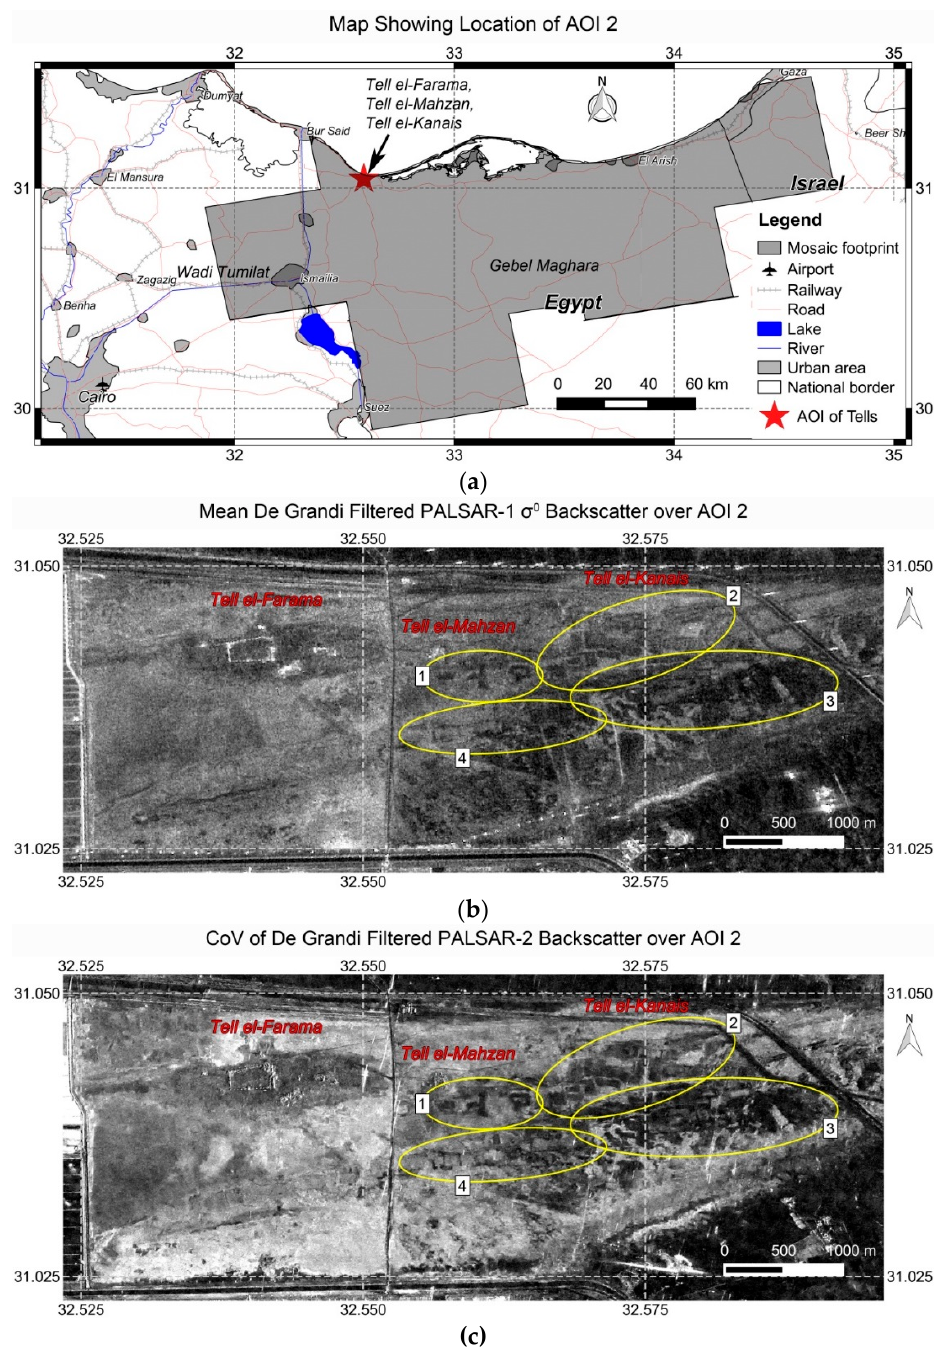
Figure 8. Cont. Figure 8.